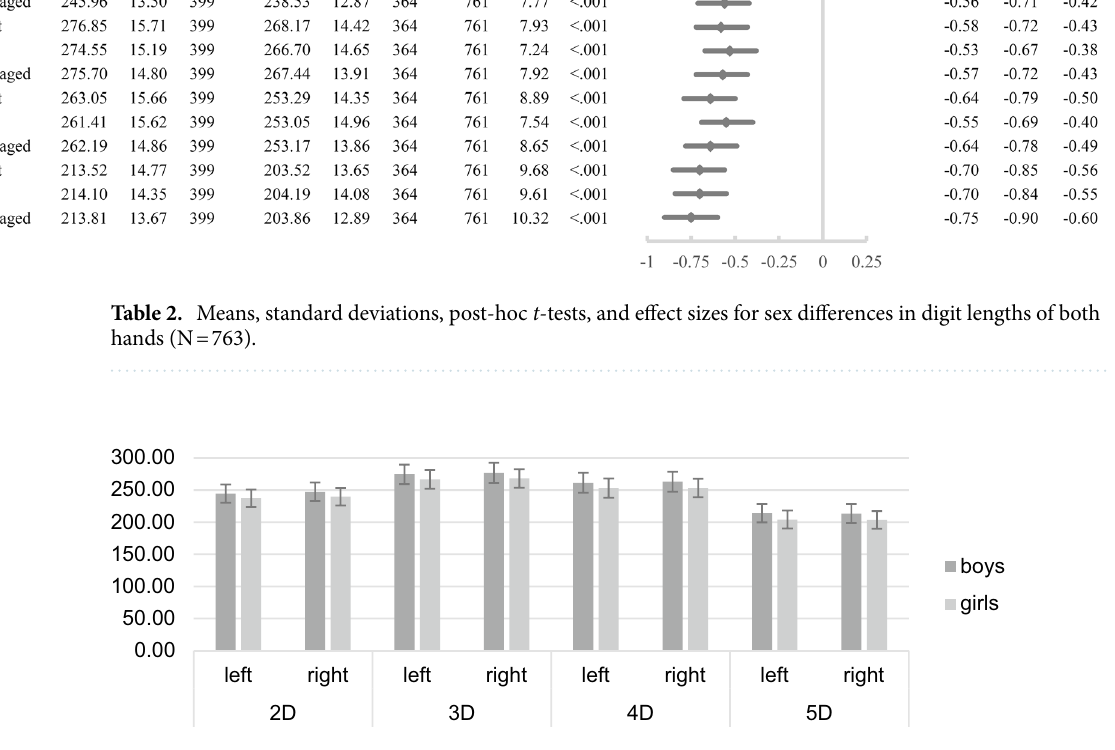
Figure 2. Means and standard deviations in right, left, and averaged digit lengths separately for boys and